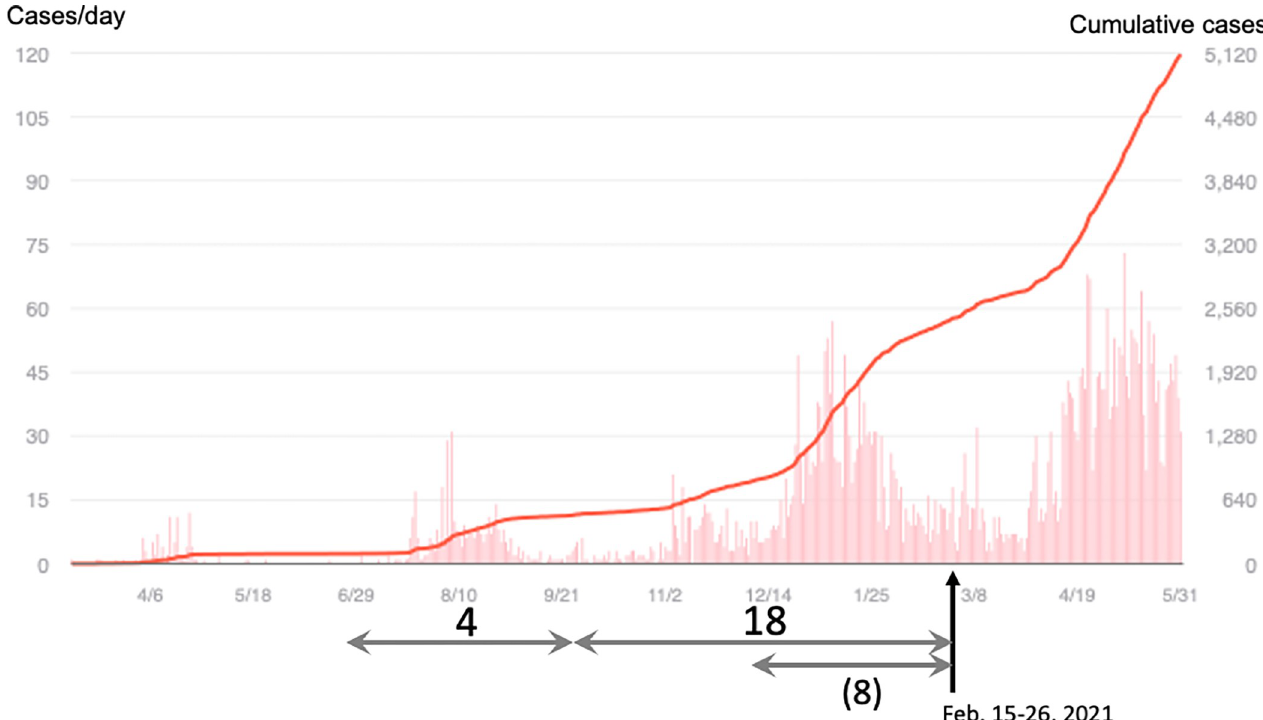
Fig 1. Numbers of new and cumulative cases of COVID-19 in Shiga Prefecture. New and cumulative cases of COVID-19 are indicated as bars and lines, respectively (https://covid2019.fa.xwire.jp/#japan_prefecture). The investigation and blood sampling were performed 15–26 February 2021, at the terminal timing of the third wave of the pandemic in Shiga Prefecture. The numbers and arrows below the graph indicate the estimated cases and timing of HCWs exposed to SARS-CoV-2. Four and 18 cases presumably suffered from SARS-CoV-2 at the second and third waves, respectively. Eight patients were likely exposed during a period of less than three months. Note . COVID-19, coronavirus disease 2019; HCW, healthcare workers; SARS-CoV-2, severe acute respiratory syndrome coronavirus